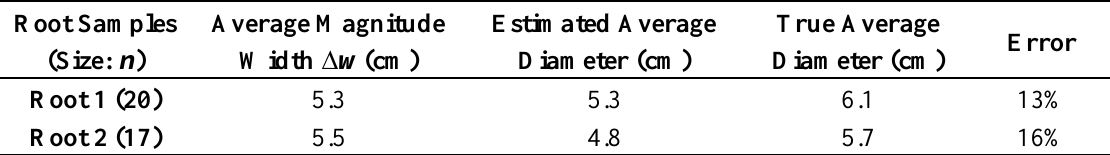
Table 4. Diameter estimated results from GPR